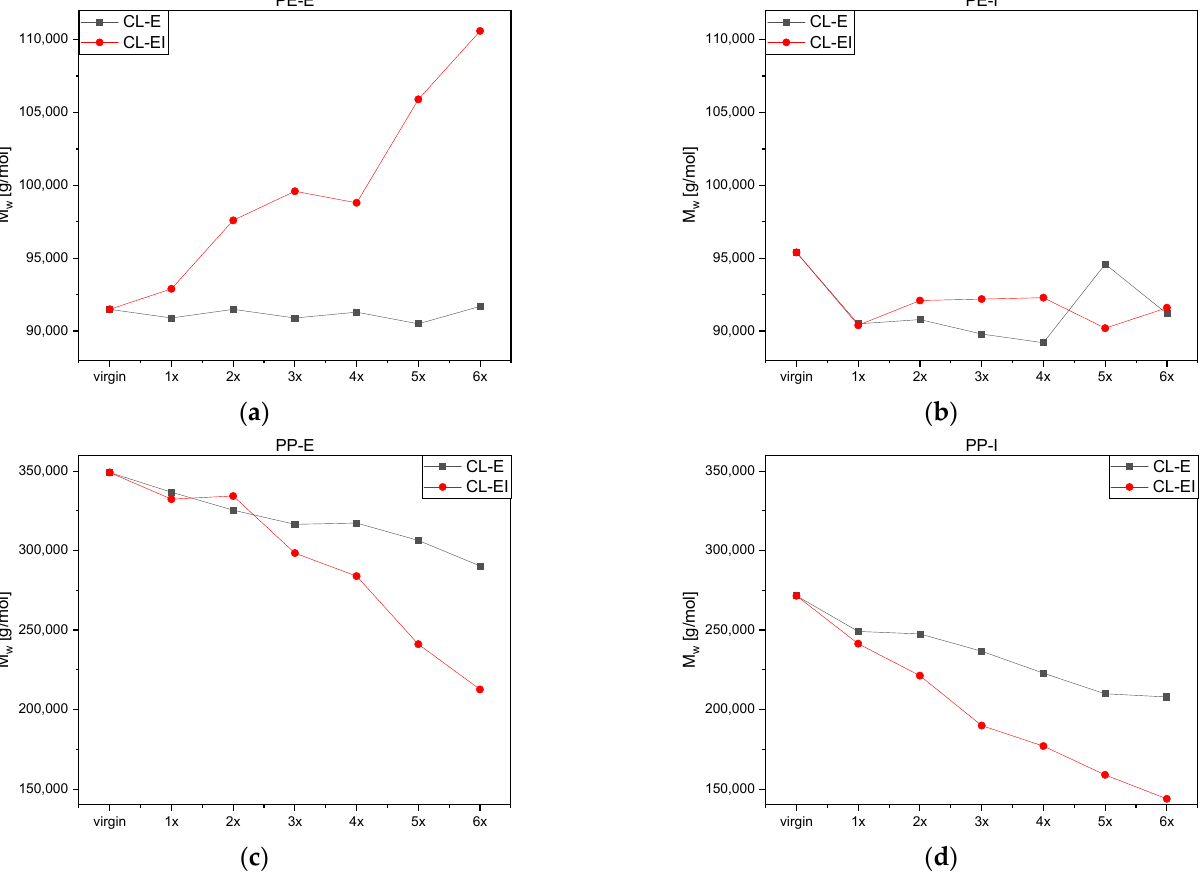
Figure 5. M w after each loop for both processing cycles: ( a ) PE-E, ( b ) PE-I, ( c ) PP-E and ( d ) PP-I.